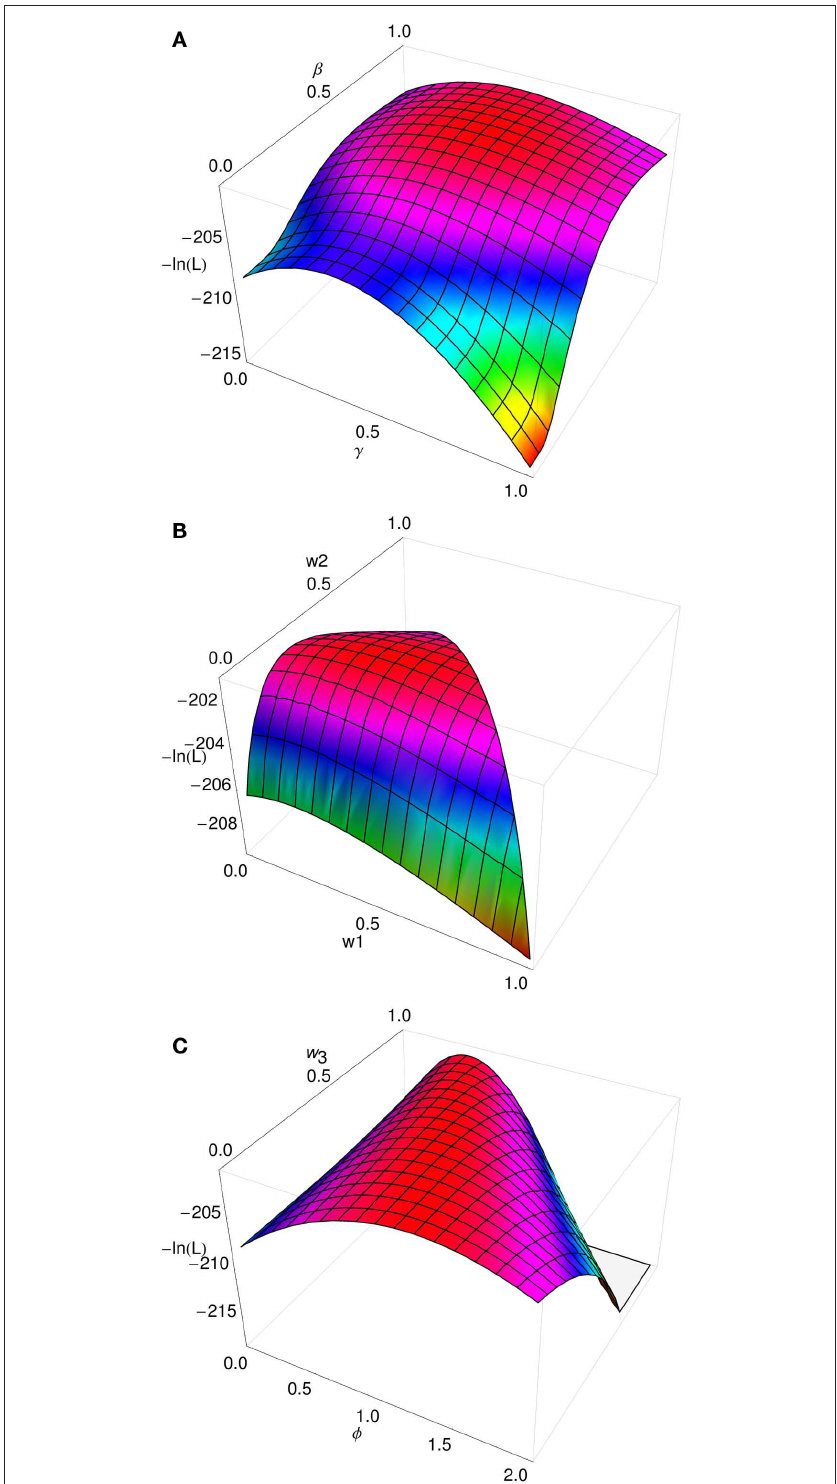
Figure 1 | The (log) likelihood of the data given the model, ln ( L ). (A) A wide range of utility and weighting function parameters provide good fits. (B) A wide range of integration modes provide a good fit. (C) Any integration mode can be fitted by adjusting response determinism. Non-graphed parameters match those of the base